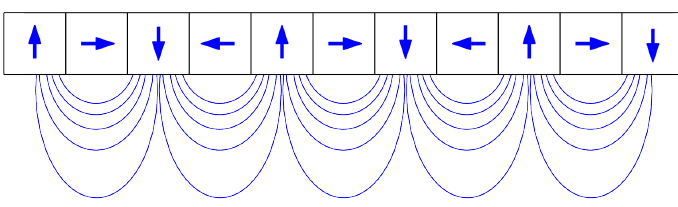
Figure 7. A Halbach array of permanent magnets. The arrows indicate the north poles, each rotated 90 ◦ from its neighbors. This scheme produces a periodic magnetic field gradient at the surface as